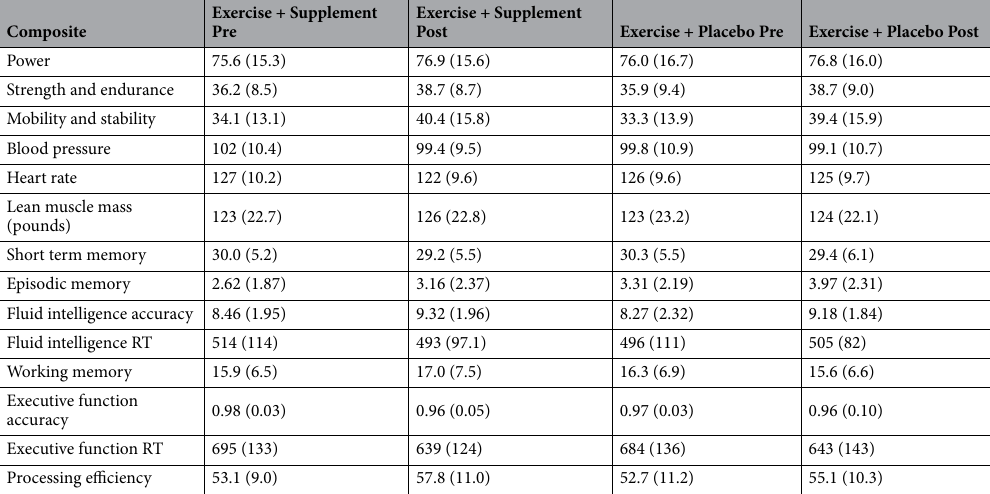
Table 1. The original version of Supplementary Table